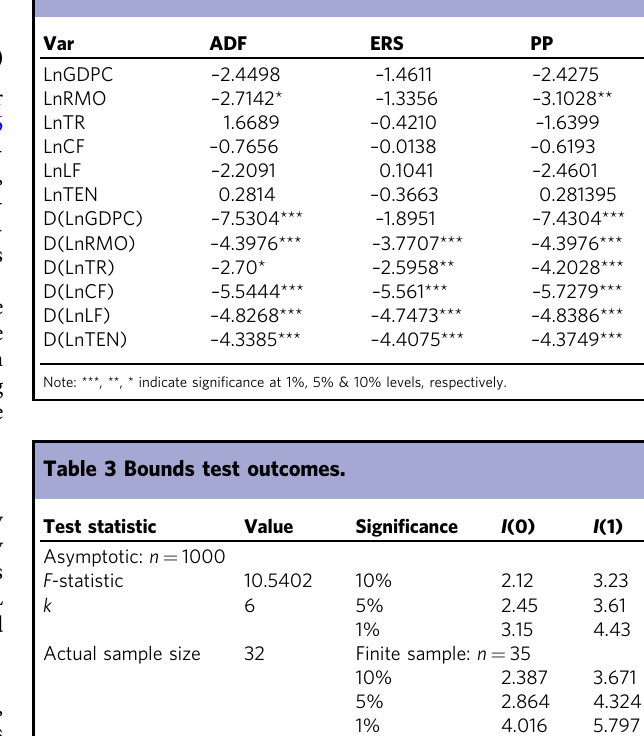
Table 2 Unit root tests outcomes.